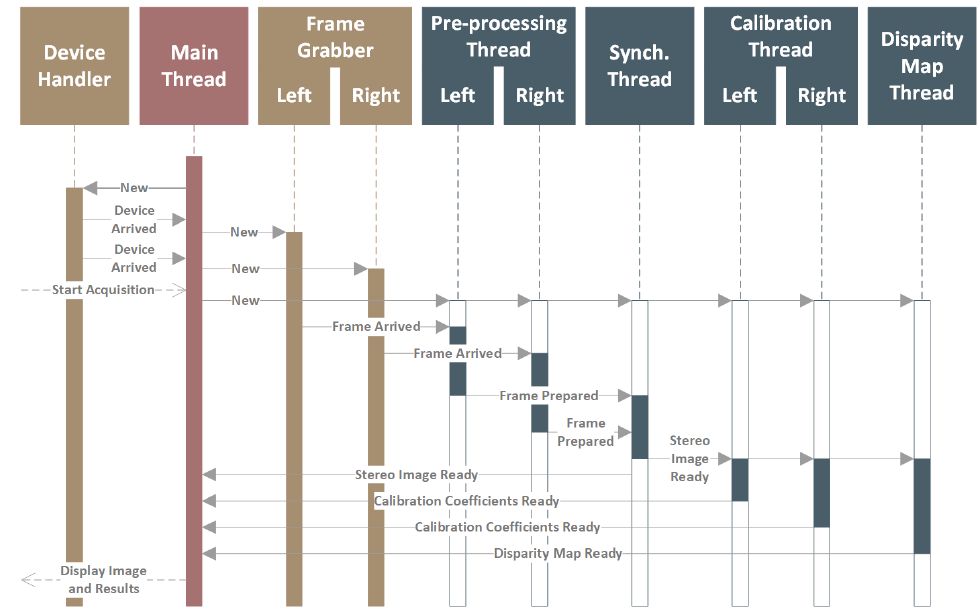
Figure 6. Multi-threaded execution sequence in the graphical user application for image acquisition, synchronisation, and